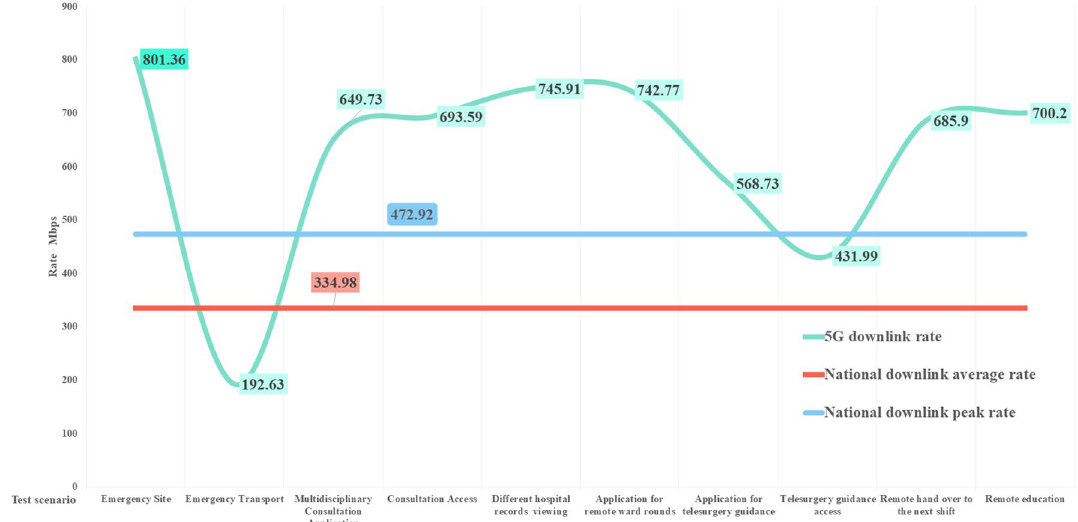
Figure 9. A comparison between the 5G downlink rate test value in the real scene and the national laboratory test average